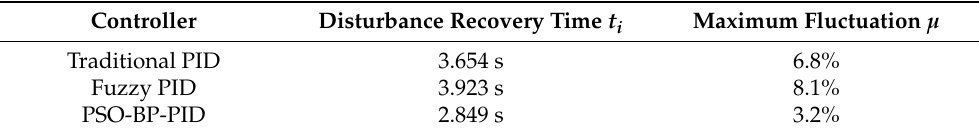
Figure 14. Anti-disturbance simulation curves.